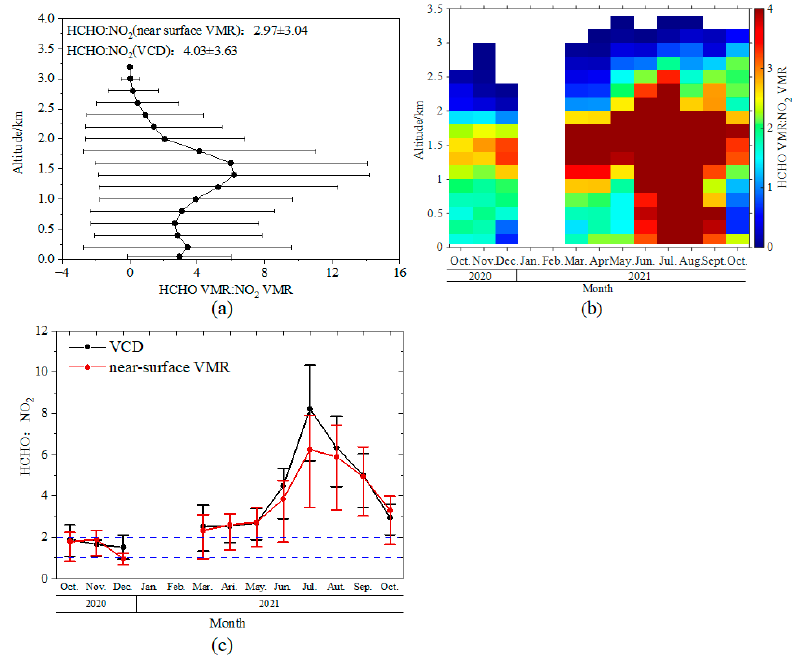
Figure 9. ( a ) Vertical profiles of the ratio of HCHO to NO 2 during the observation period. The dots and whiskers indicate the average of all data at selected altitudes during the observation period and the standard deviation, respectively. ( b ) Monthly variation of vertical profiles of VMRs ratios of HCHO to NO 2 . ( c ) Monthly variation of the ratio of HCHO to NO 2 for tropospheric VCDs and near-surface VMRs. The dots and the error bars denote the averages and the 25th and 75th percentiles of the data grouped for each month. HCHO/NO 2 = 1 and 2 are also marked with dashed lines. The white grid cells in panel ( b ) indicate the missing data owing to lacking observation and data quality